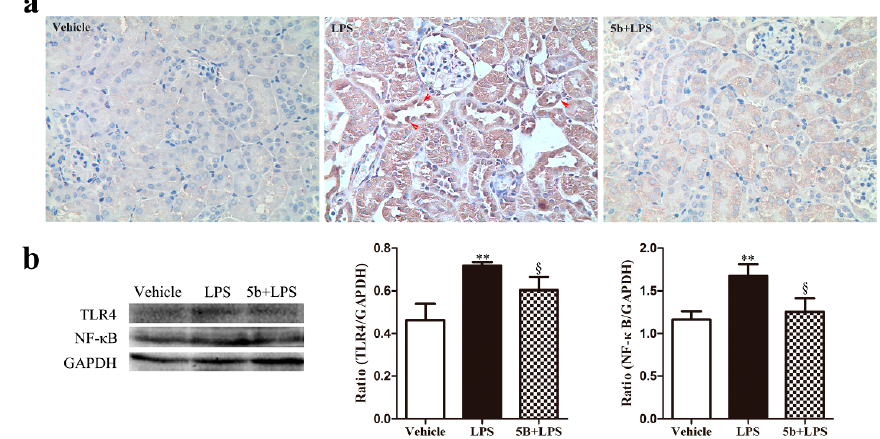
Figure 5. Effect of 5b on the expression of NF- κ B p65 and TLR4 in the kidneys of mice. Expression of NF- κ B p65 was measured using immunohistochemistry staining. ( a ) Levels of NF- κ B p65 and TLR4 proteins were measured using Western blot analysis; ( b ) Data were expressed as means ± SD for